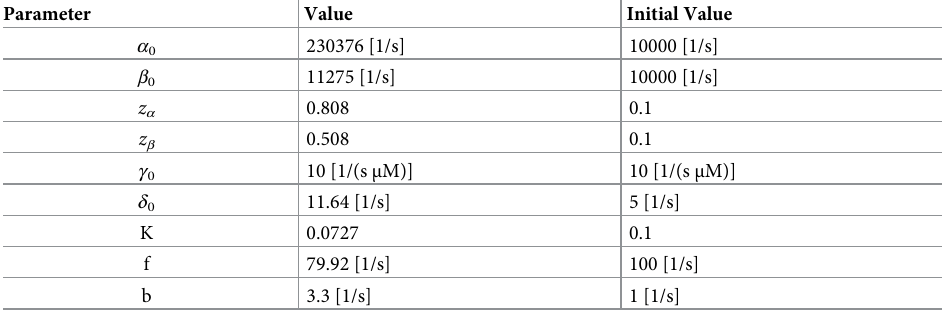
Table 3. Model parameters resulting from stochastic